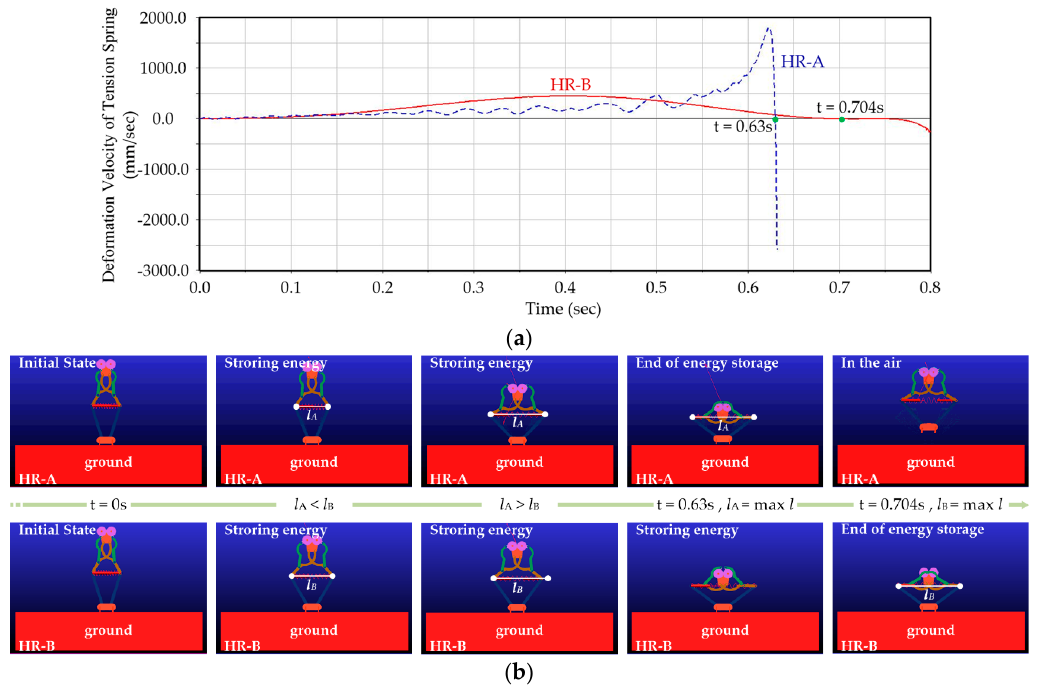
Figure 11. Comparison of simulation results for HR-A and HR-B. ( a ) The deformation velocity of the tension spring. ( b ) Key positions in the simulation. l i means the length of the tension spring.